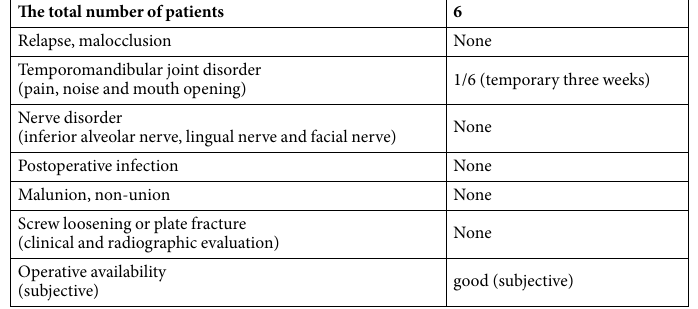
Table 1. Clinical outcome with the checklist during follow